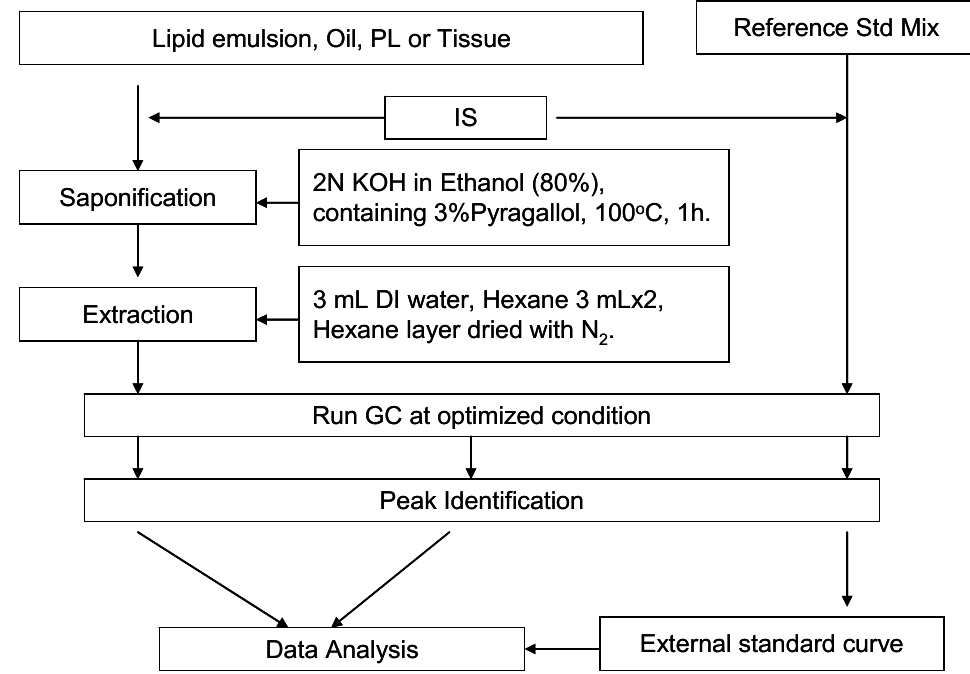
Scheme 1. Protocol for sterol